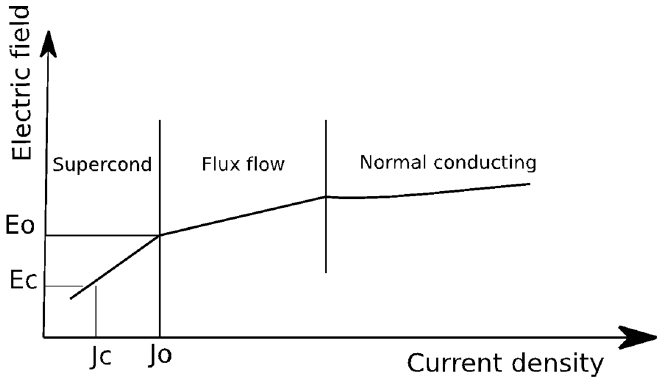
Figure 3. E-J characteristic of HTS material.